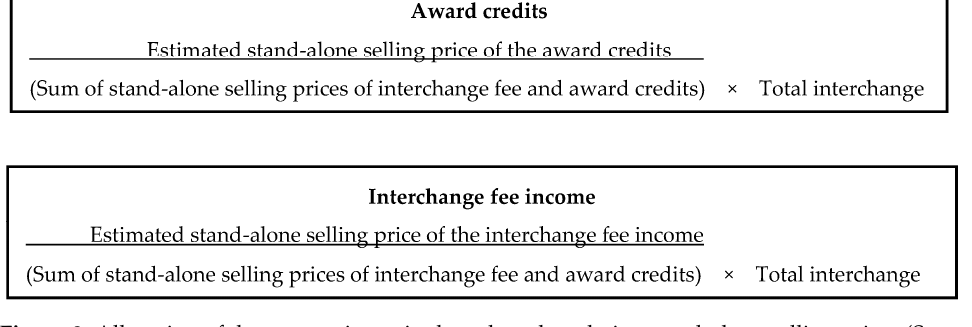
Figure 8. Allocation of the transaction price based on the relative stand-alone selling prices (Source: IASB 2014d).